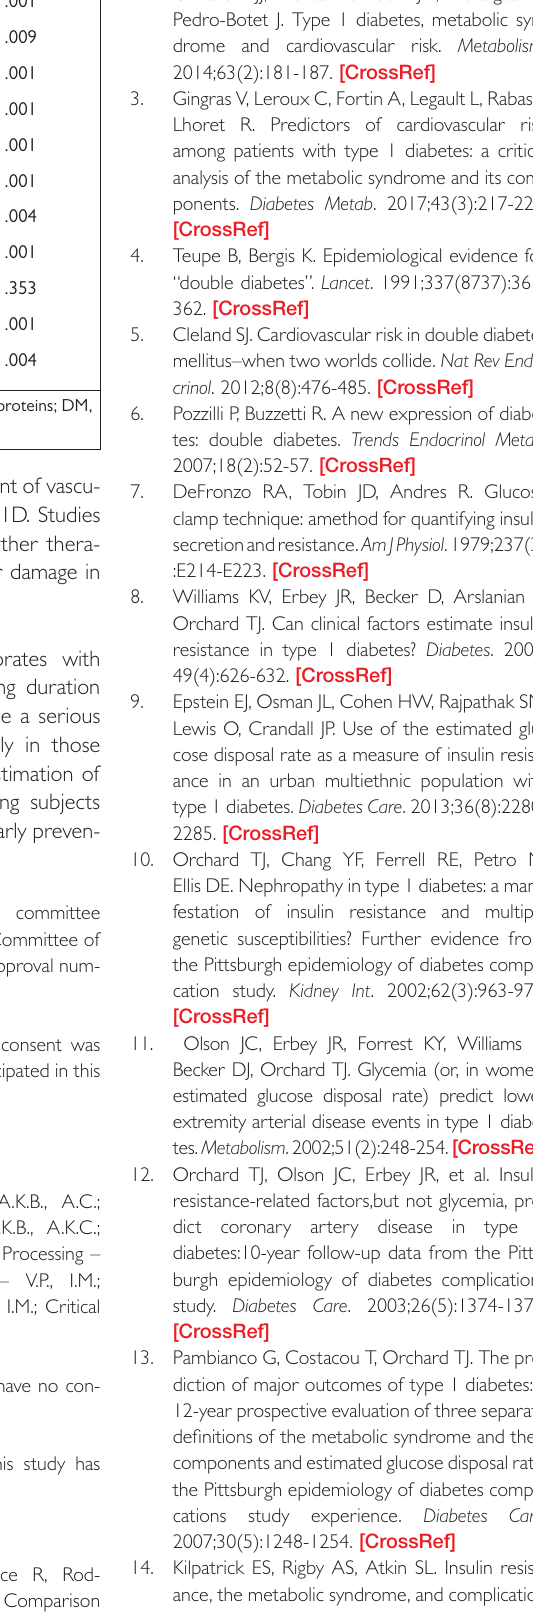
Table 5. Correlation of eGDR with Anthropometric and Metabolic Parameters Parameters Correlation Coefficient